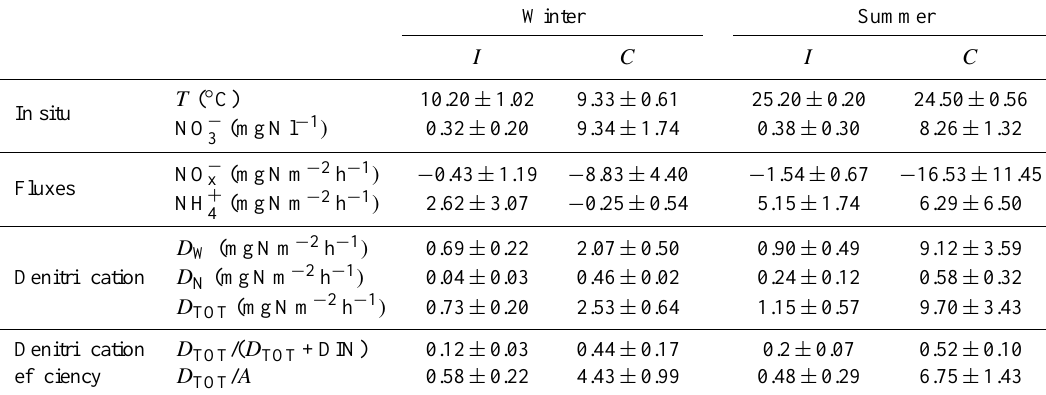
Table 2. In situ nitrate concentration and temperature, ammonium and nitrate plus nitrite fluxes, denitrification rates and denitrification efficiency measured in 12 riverine wetlands during summer and winter 2007. Half of the study sites were connected with ( C ) and half were isolated ( I ) from the Oglio River. Total denitrification ( D TOT ) was split into denitrification supported by water column nitrate ( D W ) and denitrification coupled to nitrification in sediments ( D N ) . Denitrification efficiency was calculated as the ratio between denitrification rates and inorganic nitrogen effluxes (DIN+N 2 ) across the sediment-water interface (Eyre and Ferguson, 2002) and as the ratio between denitrification and the theoretical ammonium production within sediments ( A ) (Dalsgaard,